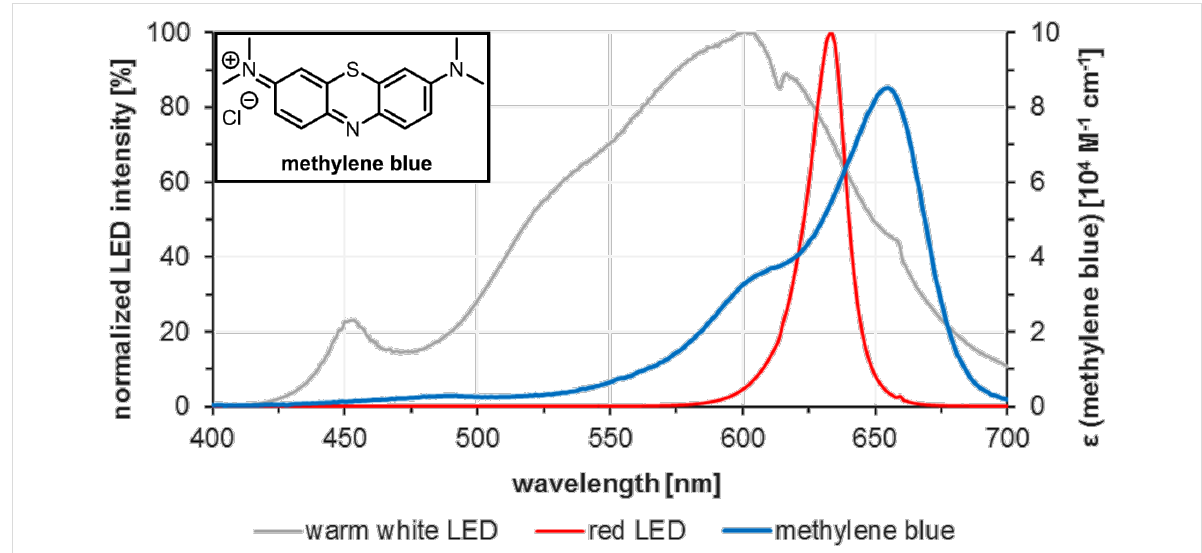
Figure 4: Overlap of absorption spectrum of methylene blue in acetonitrile and emission spectra of reasonably overlapping light sources.